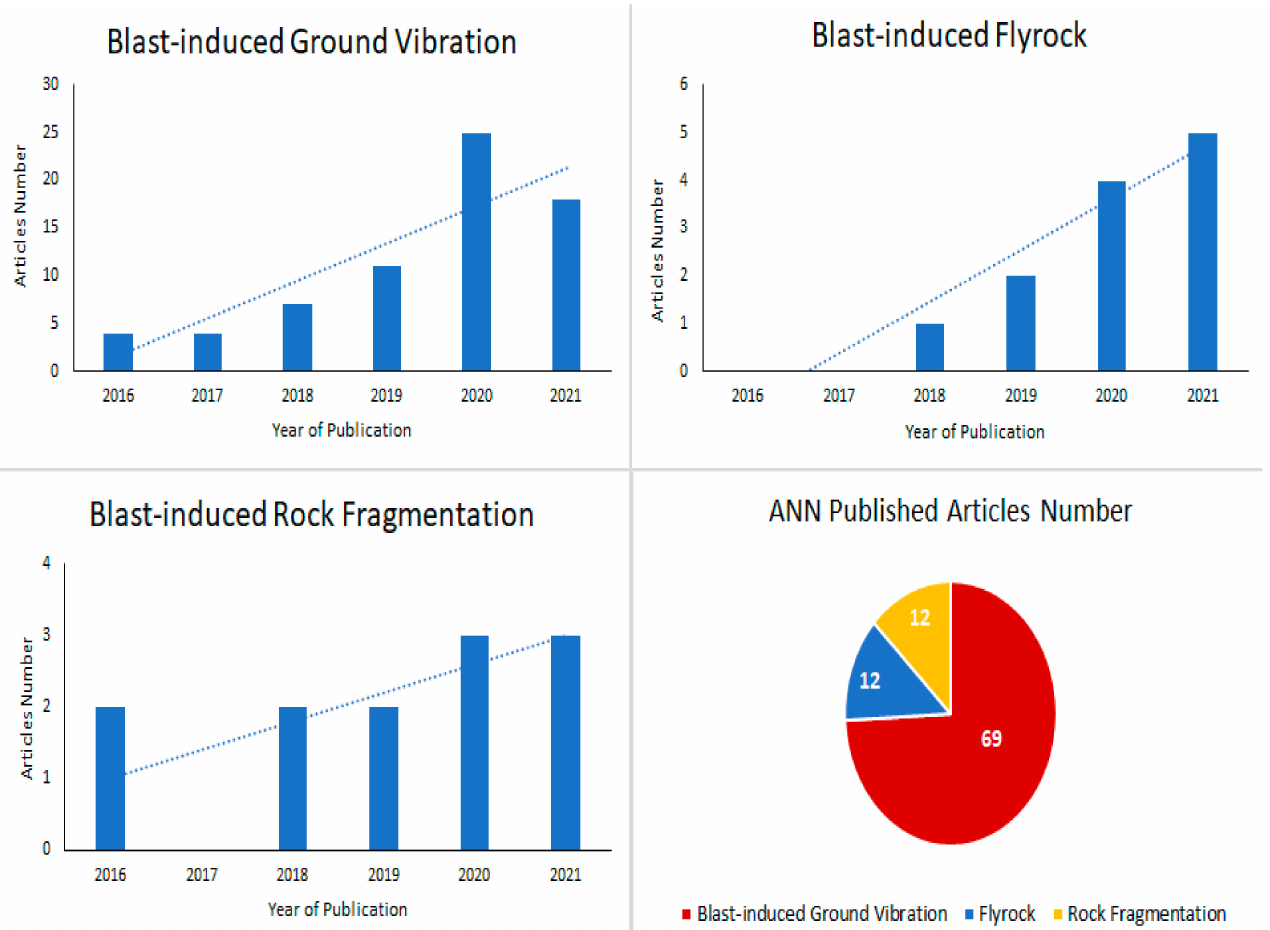
Figure 3. The trend of annual articles published recently under ANN applications for blast-induced impacts